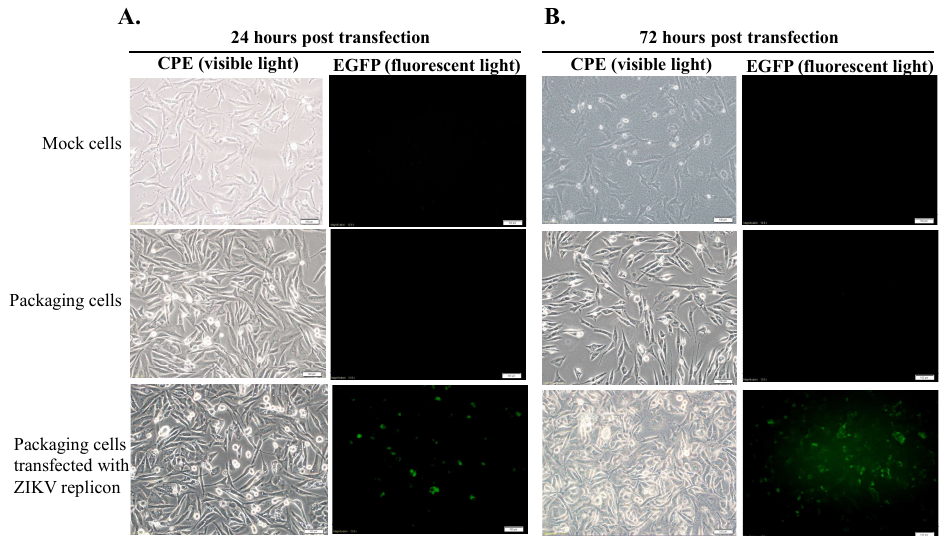
Figure 2. Analysis of the cytopathic effect (CPE) and EGFP reporter expression in prM-E-expressing packaging cells transfected with the ZIKV Natal RGN replicon. CPE and EGFP reporter expressions in mock cells (top), packaging cells (middle), and replicon-transfected packaging cells (bottom) were photographed using light and fluorescence microscopes 24 ( A ) and 72 ( B ) h post-incubation. Scale bar, 100 µm.